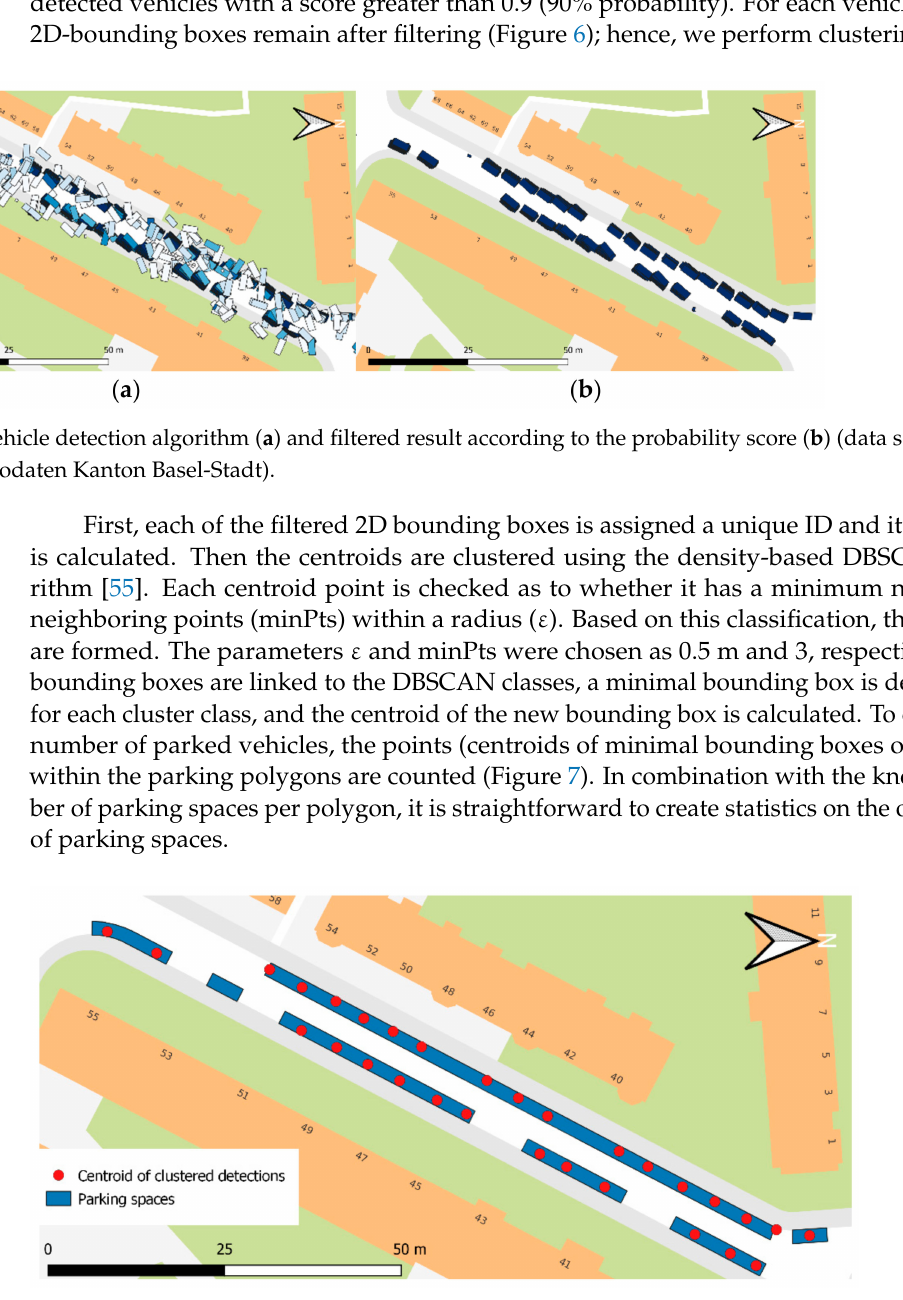
Figure 7. Result of the GIS analysis. Centroids of the clustered and filtered vehicle detections (red dots) plotted with the parking spaces (blue areas) (data source for background map: Geodaten Kanton